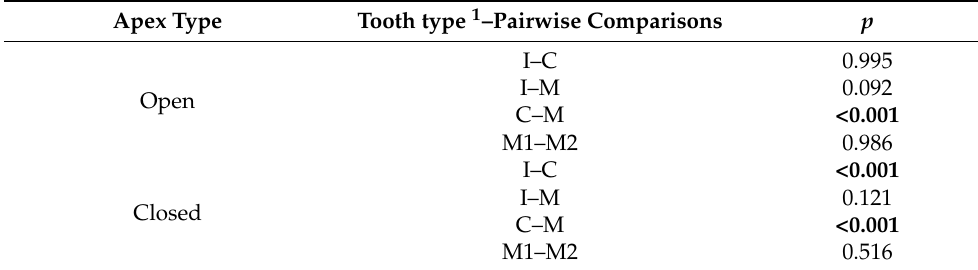
Table 2. Pairwise comparisons between primary teeth by tooth type.